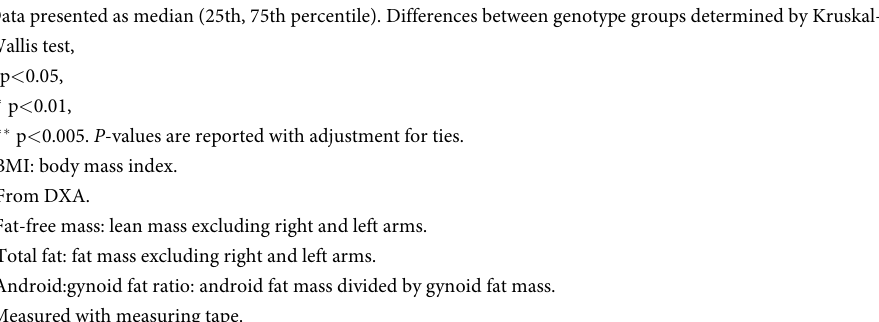
(S1 Table). Median (25th, 75th percentile) for variables of glucose tolerance and IS, for males and females, are found in S2 Table. Meal test results